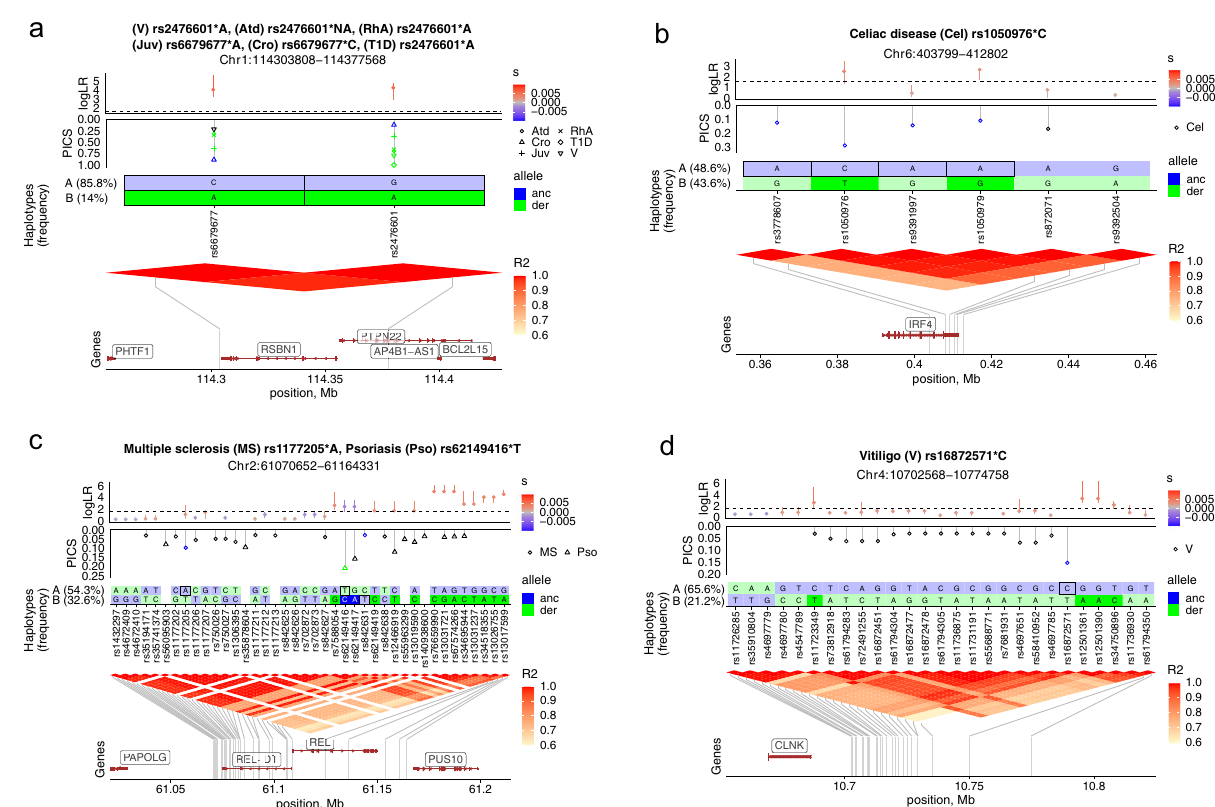
Fig. 3 | Selection targets and hitchhikers among candidate risk SNPs. a , b Disease risk and protective alleles are likely selection targets. c , d Disease risk and protective alleles are hitchhikers. Graph rows represent fi ve layers of annota- tion, from top to down- logLR, PICS, Haplotypes, LDheatmap, andGenes. The top row shows median logLR estimates with whiskers indicating minimum and max- imum of three estimates. Whisker color re fl ects the sign and magnitude of the selectioncoef fi cientestimatedontheSNPderivedallele.Thedashedlineseparates LogLR values (below) expected under the neutral demographic history of Esto- nians.Thevaluesabovesuggestevidenceforselection.ThesecondrowshowsPICS values for each candidate SNP reported in ref.35. Candidate SNPs for multiple diseasesareshownwithdifferentsymbols.Thesymbolisbluewhentheriskalleleis